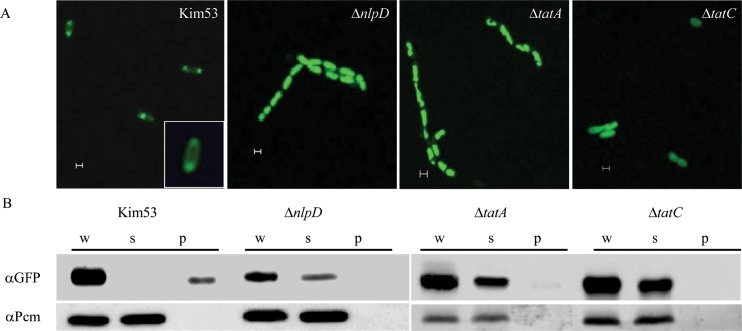
Intracellular localization of the TorAsignal-GFP Tat-reporter protein in Y. pestis strains.A. Y. pestis strains Kim53:pTorAsignal-GFP, Kim53ΔnlpD:pTorAsignal-GFP Kim53ΔtatA:pTorAsignal-GFP, and Kim53ΔtatC:pTorAsignal-GFP, were inspected under a fluorescence microscope for identification of TorAsignal-GFP localization. The scale bar represents 1 μm. B. Y. pestis cells overproducing TorAsignal-GFP were fractionated into Whole cell (W), spheroplast (S) and periplasm (P), and were subject to immunoblotting with antibodies against GFP or against the cytoplasmic protein Pcm [20]. The blots were derived from the same experiment and were processed in parallel. The data presented are representative of at least two independent experiments and the displayed data is one representative experiment.